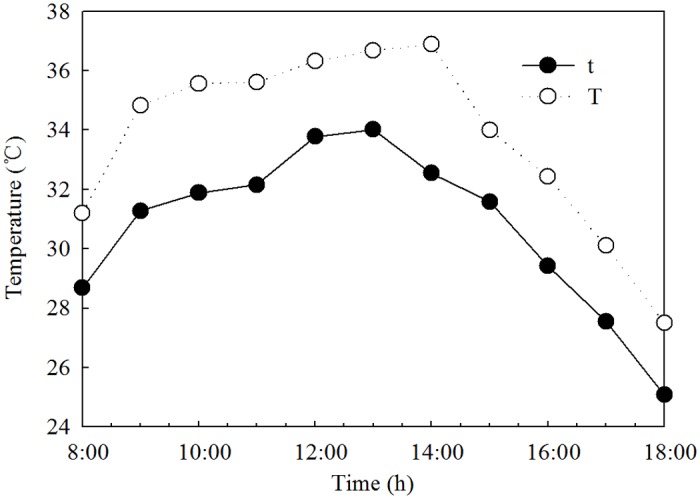
Diurnal changes of mean temperature inside and outside the sheds.T and t represent the elevated temperature and ambient temperature conditions, respectively. Hourly value was averaged over 5 days’ measurements.